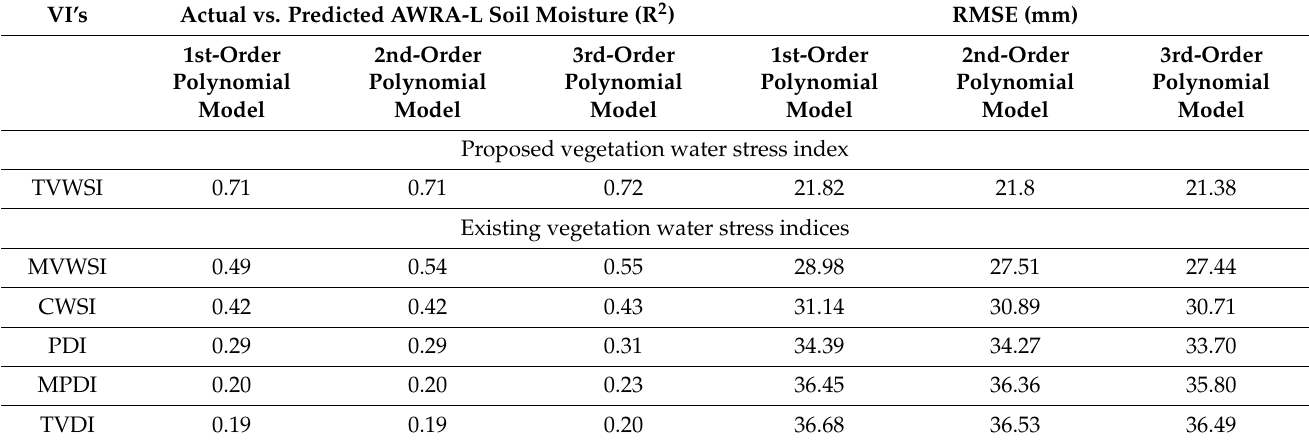
Figure 10. Density scatter plots of weekly values from sixty study sampling windows: Actual AWRA-L soil moisture vs. Predicted AWRA-L soil moisture, the predicted soil moisture values are corresponding to the first-order polynomial model fitted on the AWRA-L soil moisture and remotely sensed indices: ( a ) TVWSI, ( b ) MVWSI, ( c ) CWSI, ( d ) PDI, ( e ) MPDI, and ( f ) TVDI. The model equation, R 2 (Actual vs. Predicted AWRA-L soil moisture), RMSE (Actual vs. Predicted AWRA-L soil moisture), is shown at each of the scatter plots. The color represents the number of observations in each pixel. Table 2. R 2 (index vs. AWRA-L soil moisture) and RMSE (Actual vs. Predicted AWRA-L soil moisture) corresponding to the first-, second-, and third-order polynomial model fitted to AWRA-L soil moisture vs. TVWSI, MVWSI, CWSI, PDI, MPDI, and TVDI.